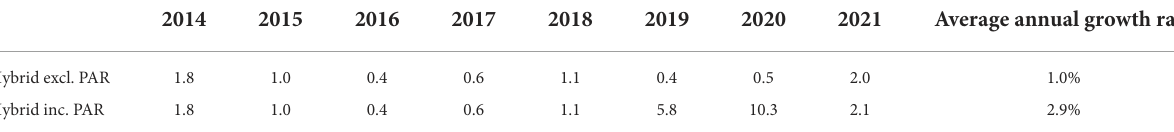
Hybrid excl. PAR Hybrid inc. PAR